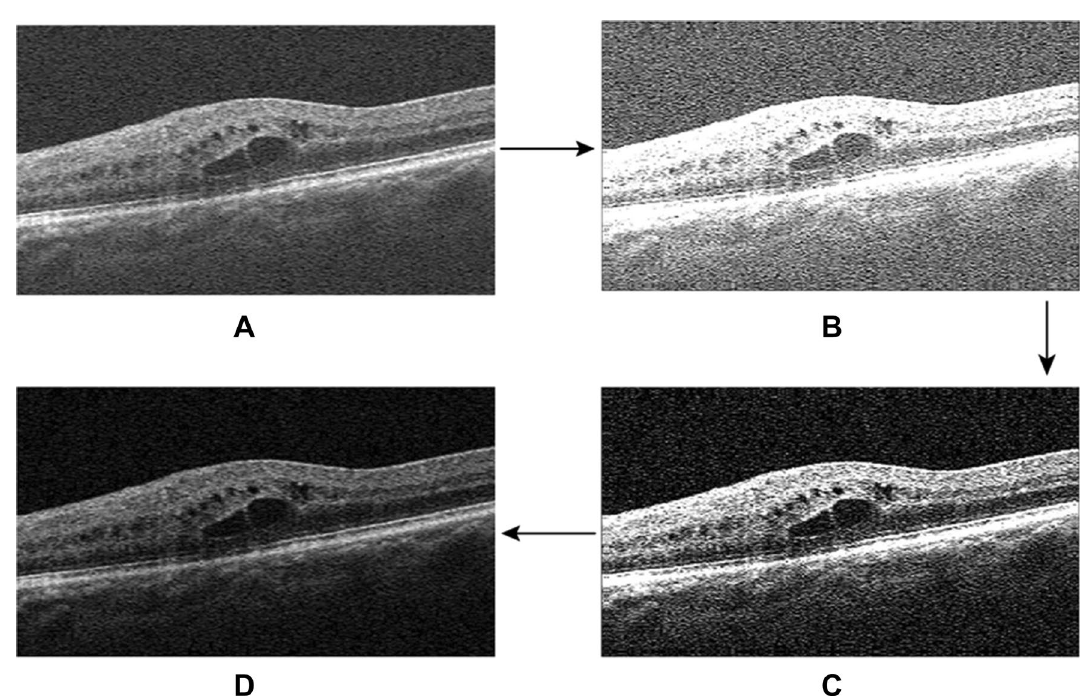
Figure 4. Denoising flowchart of OCT image. ( A ) Original OCT image. ( B ) Low-frequency band of OCT image. ( C ) Low-frequency band of OCT image by reducing speckle noises. ( D ) Reconstitution of OCT